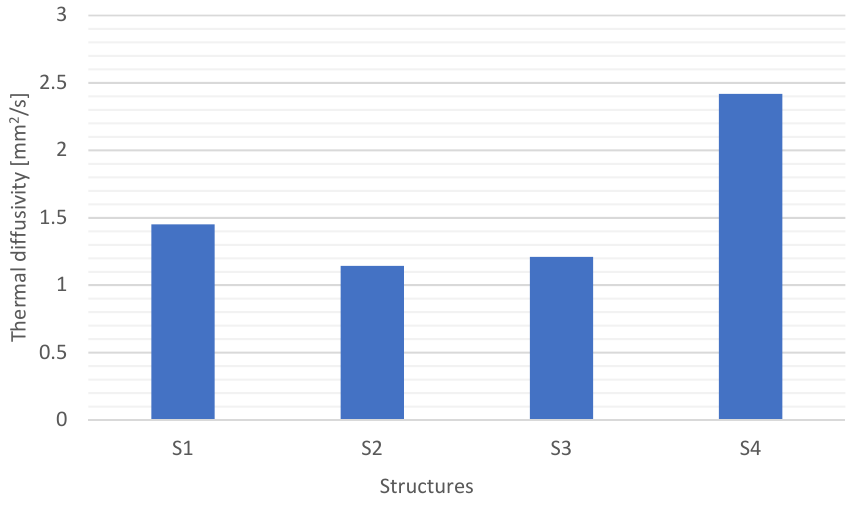
Figure 8. Temperature change during heating. The thermal diffusivity was determined based on temperature changes in time during fastest (10.52 s), and in the final stage, a minimum temperature drop was observed. S4 also showed the highest temperature: 25.57 ◦ C. The difference between the initial and the highest temperature was 3.48 ◦ C. S3 structure reached the stabilized temperature in 17.71 s. The difference between the initial and maximum temperature was 3.19 ◦ C. It and S2 structures stabilized the longest: 23.2 s. It is related to the type and properties of the reinforcement. Structures S1 and S2 have the lowest specific heat and the highest glass content. The higher the glass reinforcement content, the lower the specific heat. In addition, the glass fabric used is relatively difficult to impregnate, which has an impact on thermal diffusivity.